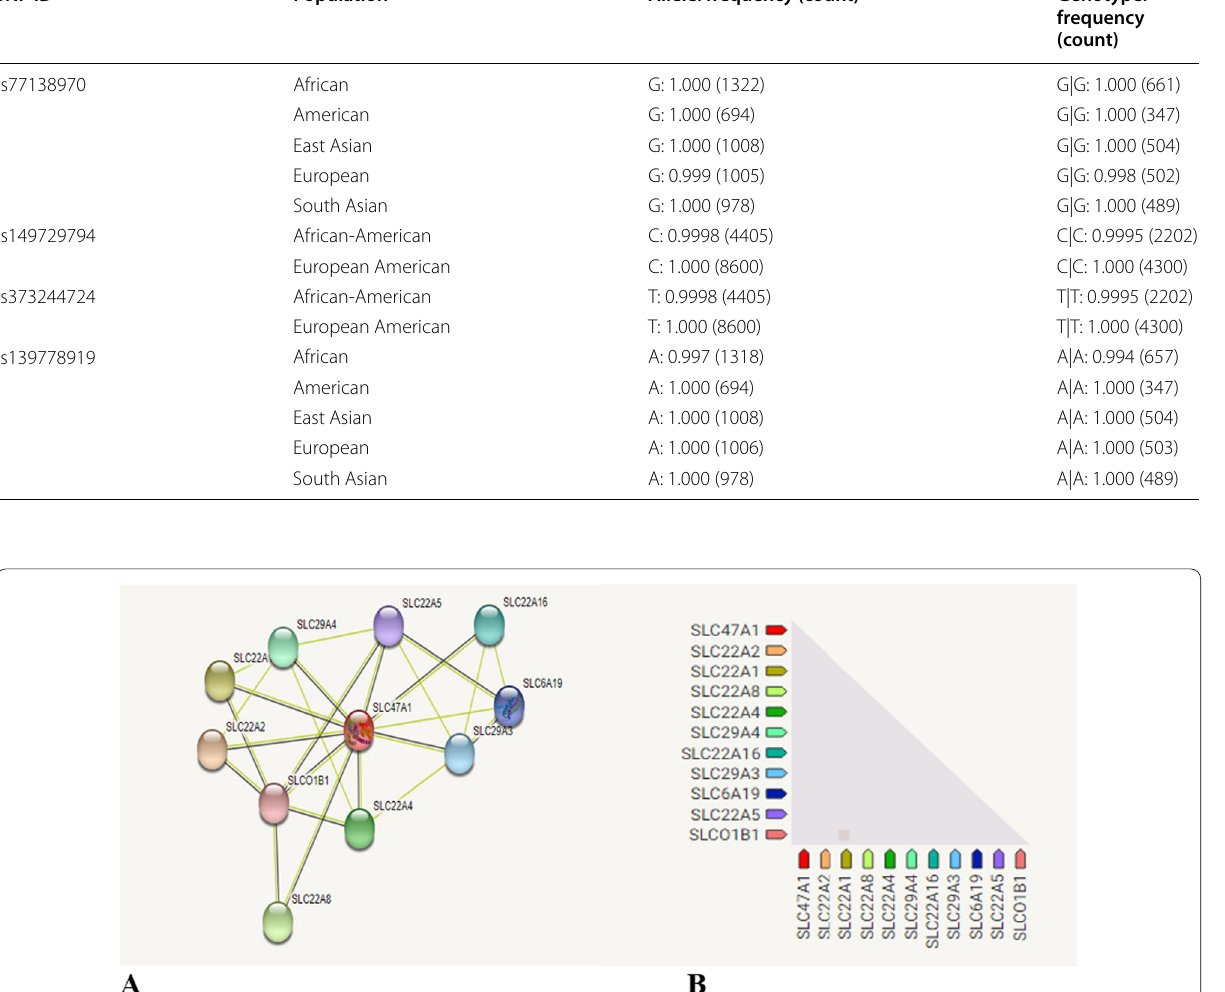
Table 5 Allele and genotype frequencies of the known high-risk missense SNPs in different populations SNP ID